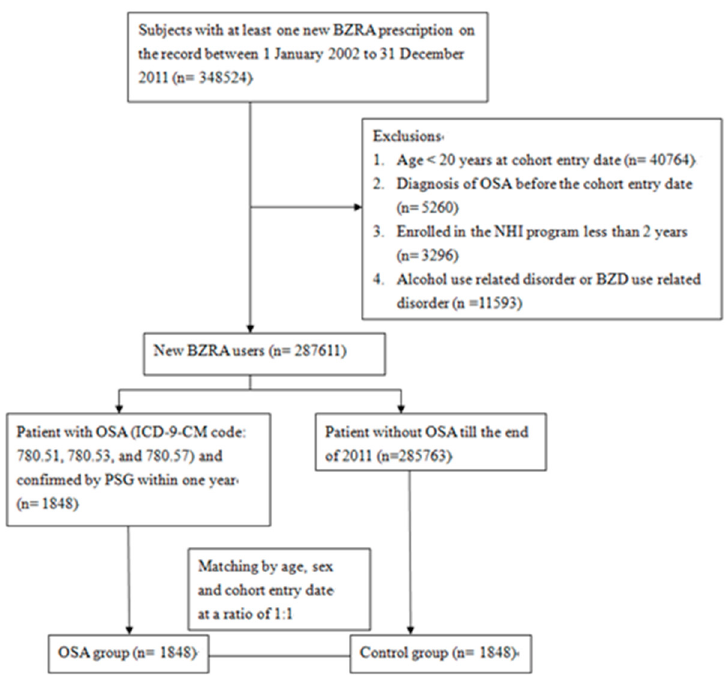
Figure 1. Flow chart of selection of study subjects from Taiwan National Health Insurance Database. ICD-9-CM = International Classification of Disease, Ninth Revision, Clinical Modification. BZRA = benzodiazepine receptor agonist. NHI = National Health Insurance. OSA = obstructive sleep apnea. PSG= polysomnography.